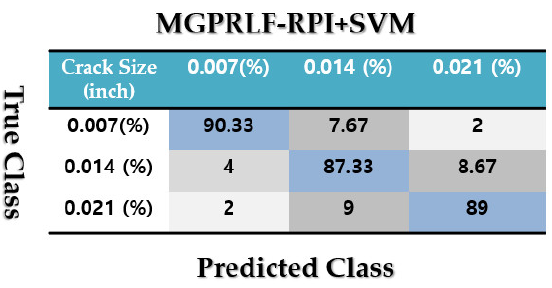
Figure 17. The average accuracies of crack size identification for the RF, IF, and OF using the pro- posed MGPRLF-RPI+SVM scheme.